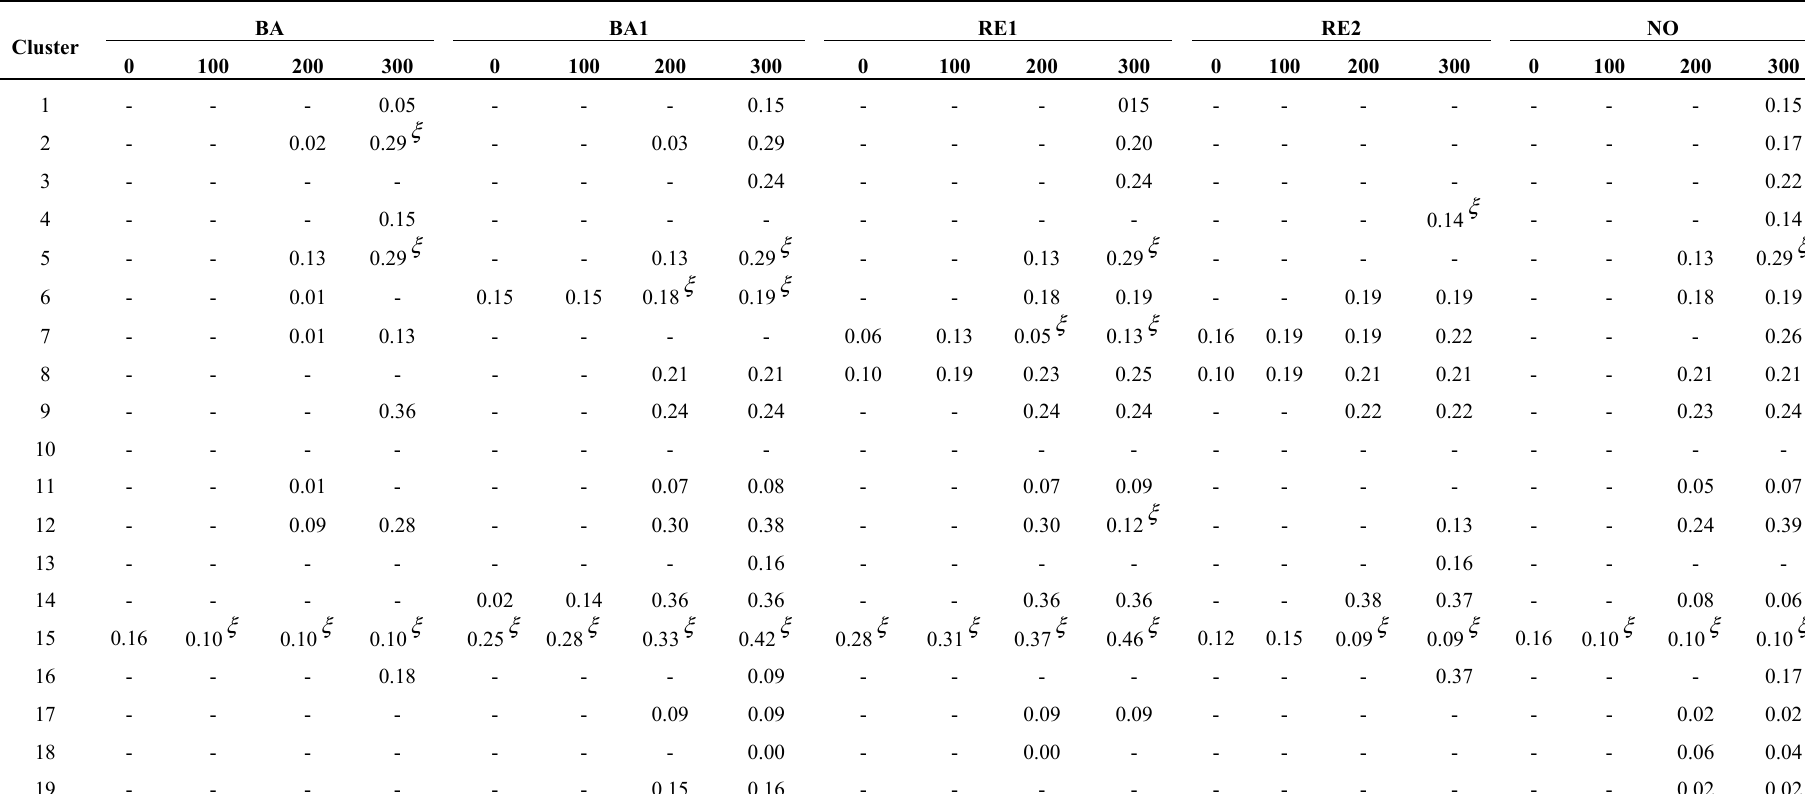
Table 5. The diffusion of SRC consistent with the introduction AECP (UAA allocated to